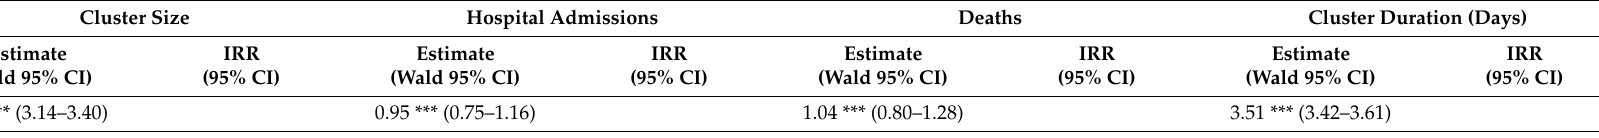
Table 5. Multivariate analysis of factors influencing the nursing home cluster characteristics (size, hospital admissions, deaths, duration) (negative binomial regression) for the period from 22 June 2020 to 2 January 2022,